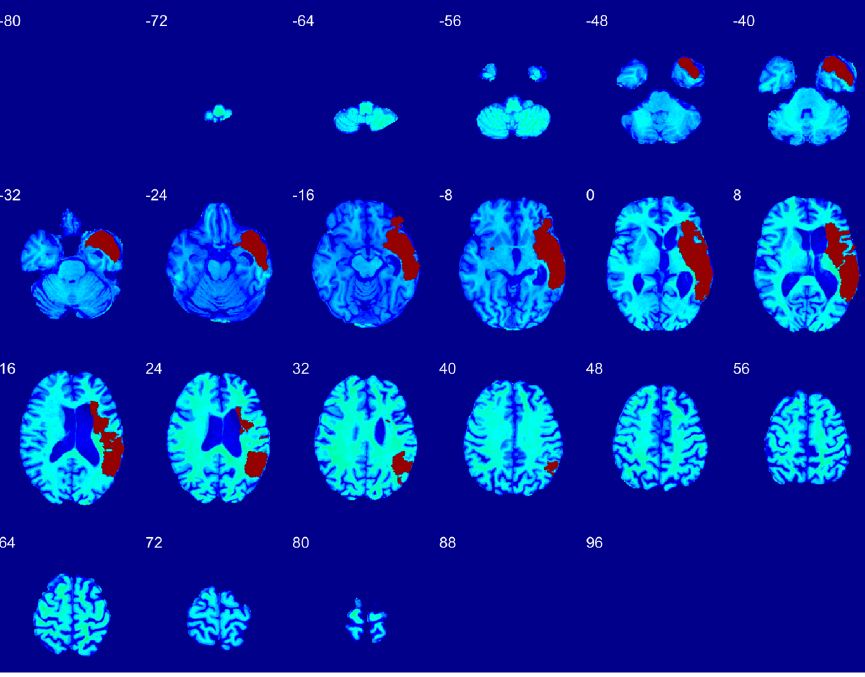
Figure 6. Axial sections showing automatic segmentation of left MCA stroke.